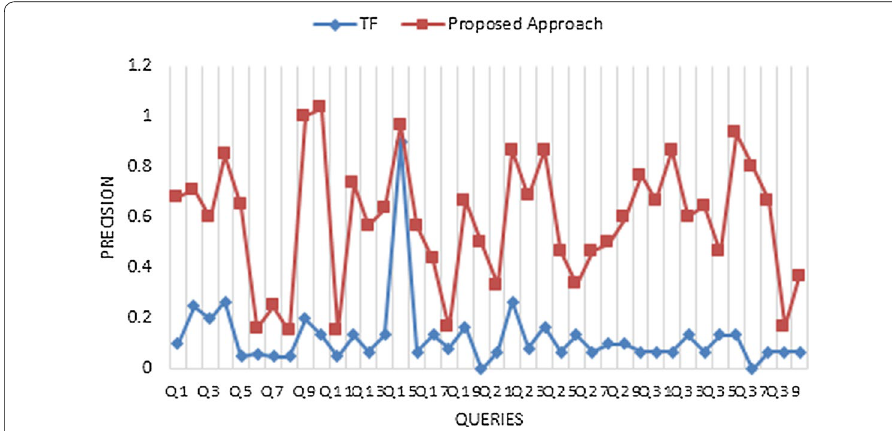
Fig. 5 Accuracy of proposed approach versus TF based approach